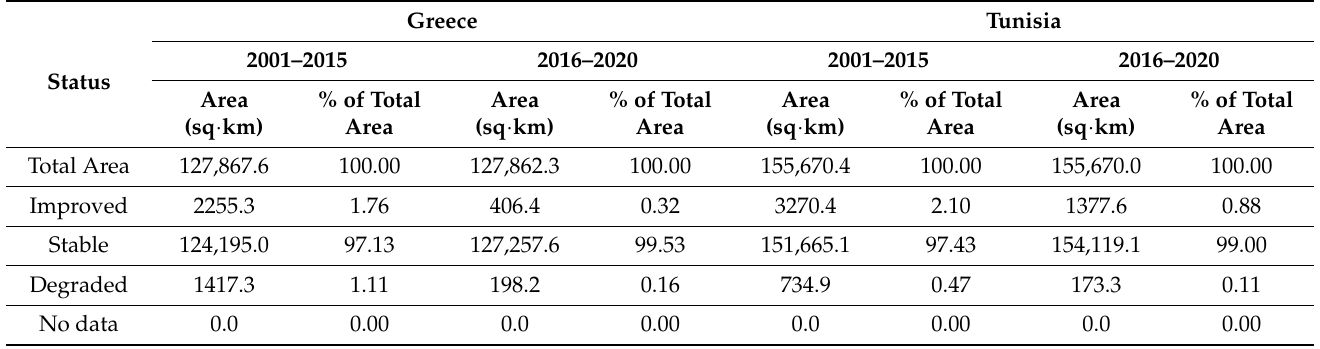
Table 4. Land cover metrics for the baseline and reporting periods in Greece and Tunisia.